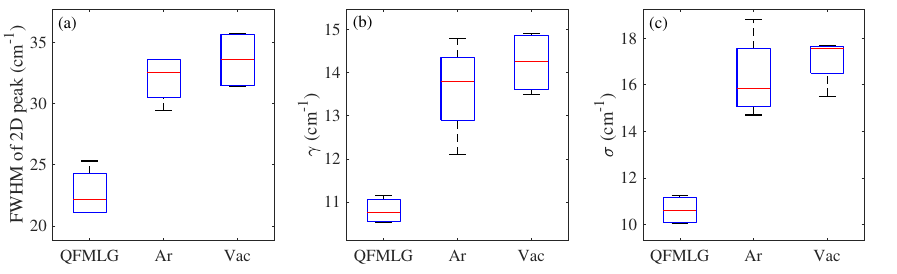
Figure 4. The ( a ) FWHM and ( b , c ) Voigt fitting parameters of ( b ) homogeneous ( γ ) and ( c ) inhomogeneous ( σ ) broadening are compared for the three samples (QFMLG, SLG-Ar, SLG-vac). Table 2. Fitted parameters γ and σ of Voigt line shape and FWHMs for three samples (QFMLG, SLG-Ar, SLG-vac). The line shape was determined at four different positions on each